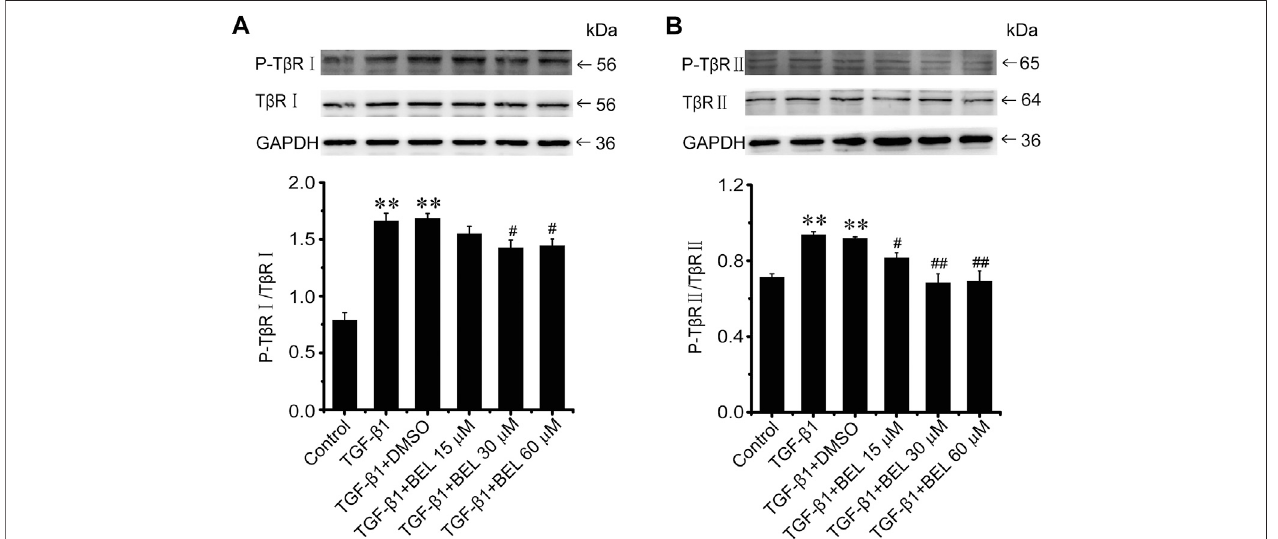
FIGURE 5 | BEL suppresses the T β R phosphorylation induced by TGF- β 1 in CFs (A and B) Western blotting detects T β R Ⅰ and T β R Ⅱ expression and phosphorylation level. Bar graphs show fold changes for the ratio of phosphorylated (P)-T β RI/T β RI, and P-T β R Ⅱ /T β R Ⅱ as analyzed by western blotting. GAPDH was used as a loading control ( n (cid:2) 3). Data were shown as mean ± SEM. ** p < 0.01 vs. control, # p < 0.05 vs. TGF- β 1, ## p < 0.01 vs. TGF- β 1.